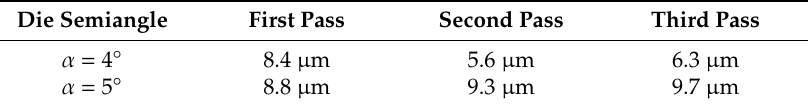
Table 4. Dependence of t on the number of passes and α .